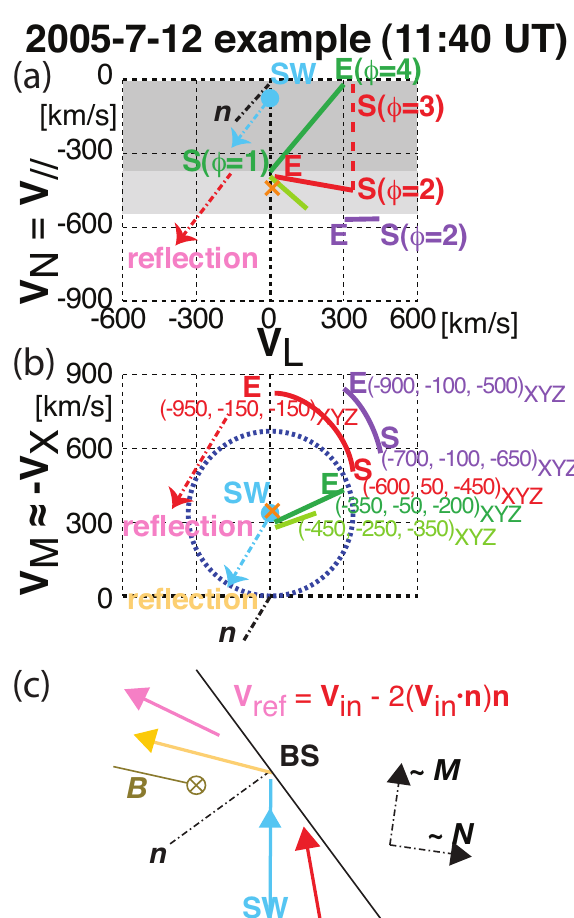
Fig. 9. Illustration of velocity space trajectory in the L - M - N coor- dinate depicted from the 11:39:36 ∼ 11:42:48UT data (second scan) of Fig. 8, where N = ( + 0.2, + 0.8, + 0.55) is the magnetic field orientation that is estimated from the ring distribution (light-blue dashed circle. The local bow shock (BS) normal direction ( n ) is as- sumed to be ( + 0.6, − 0.8, 0) in MSO coordinates, and is drawn with dash-dotted lines. (a) L - N projection of velocity space ion trajec- tories at around 11:40 ∼ 11:41UT. (b) L - M projection of velocity space ion trajectories at around 11:40 ∼ 11:41UT. (c) The local BS configuration in MSO coordinates ( + X MSO points downward and + Y MSO points rightward). In (a) and (b) , solid lines represent ve- locity space trajectory during the gyration (start and end point in the observed phase-space are marked as S and E, respectively under as- sumption of B // − N ), whereas dash-dotted arrows represent jumps in velocity due to specular reflection at the bow shock. Point S of the red and purple lines correspond to the starting elevation angle ( θ = 0 in Fig. 2), and the quadrant below S in (b) is outside the field-of-view of IMA. The orange cross indicates the de Hoffman- Teller velocity V HT = n × ( V SW × B )/( B · n ) . The value of φ in the L - N projection is the azimuthal sector number that recorded the ions in Fig. 7. The ion trajectories marked by the green and light green lines in (a) and (b) corresponds flows nearly along the BS, and the start point of the green line overlaps with V HT